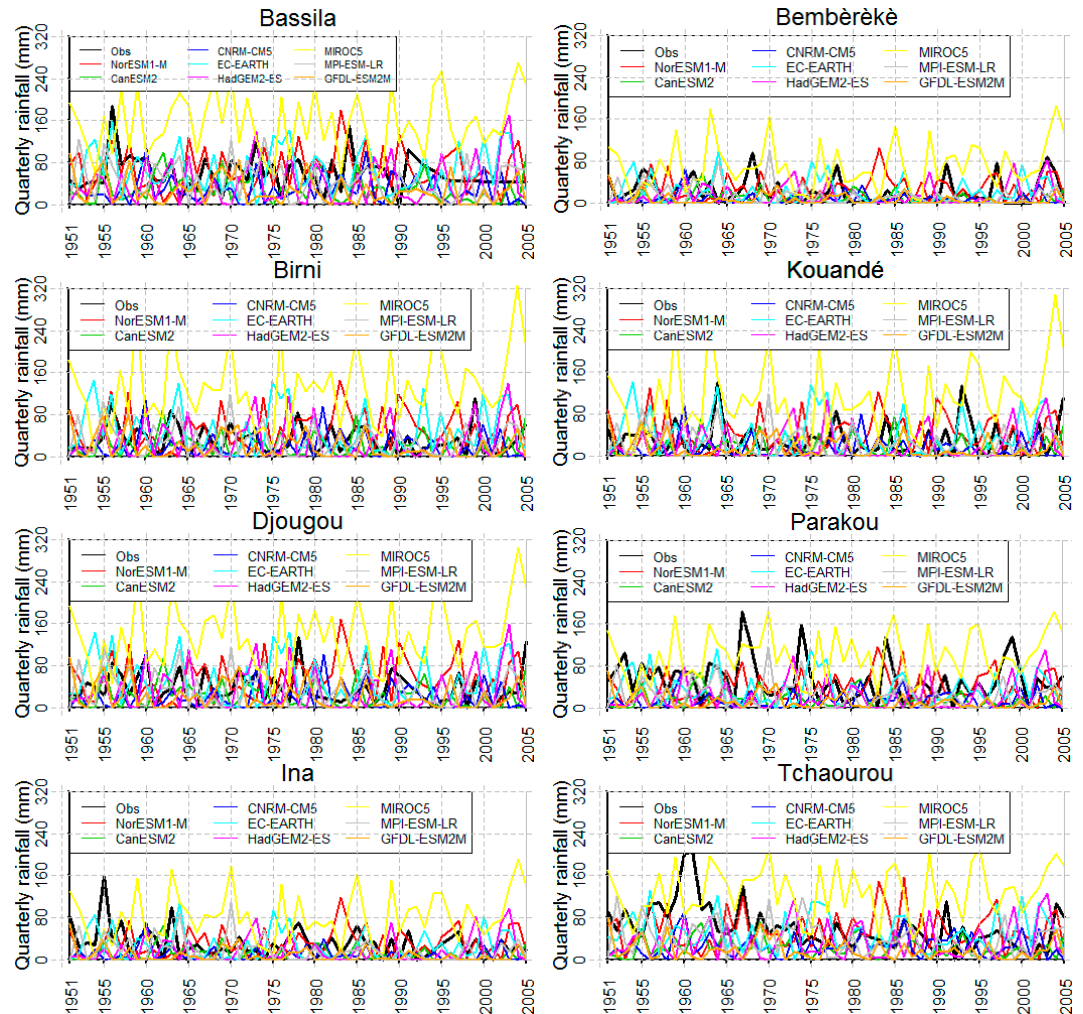
Figure 6. First quarter total rainfall evolution. Table 9. Results of statistical criteria for first quarter total precipitation.